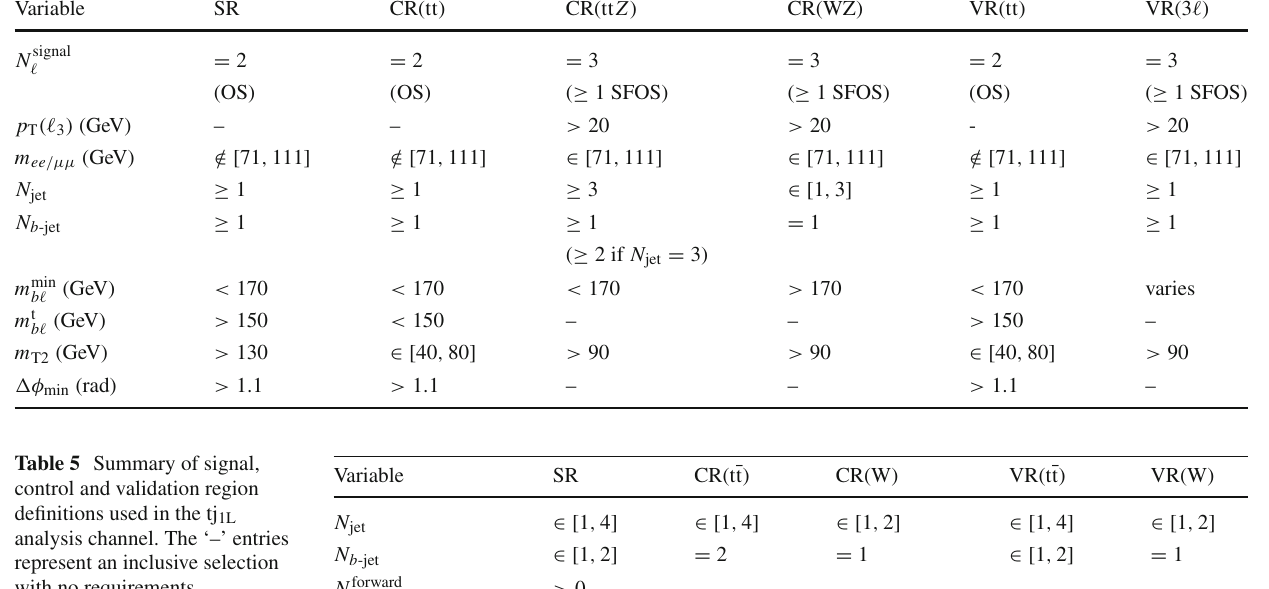
in the main text. The selection requirement on the corrected m min the VR ( 3 (cid:7)) region varies according to the jet and b -jet multiplicity as described in the main text. Events with additional baseline leptons are vetoed